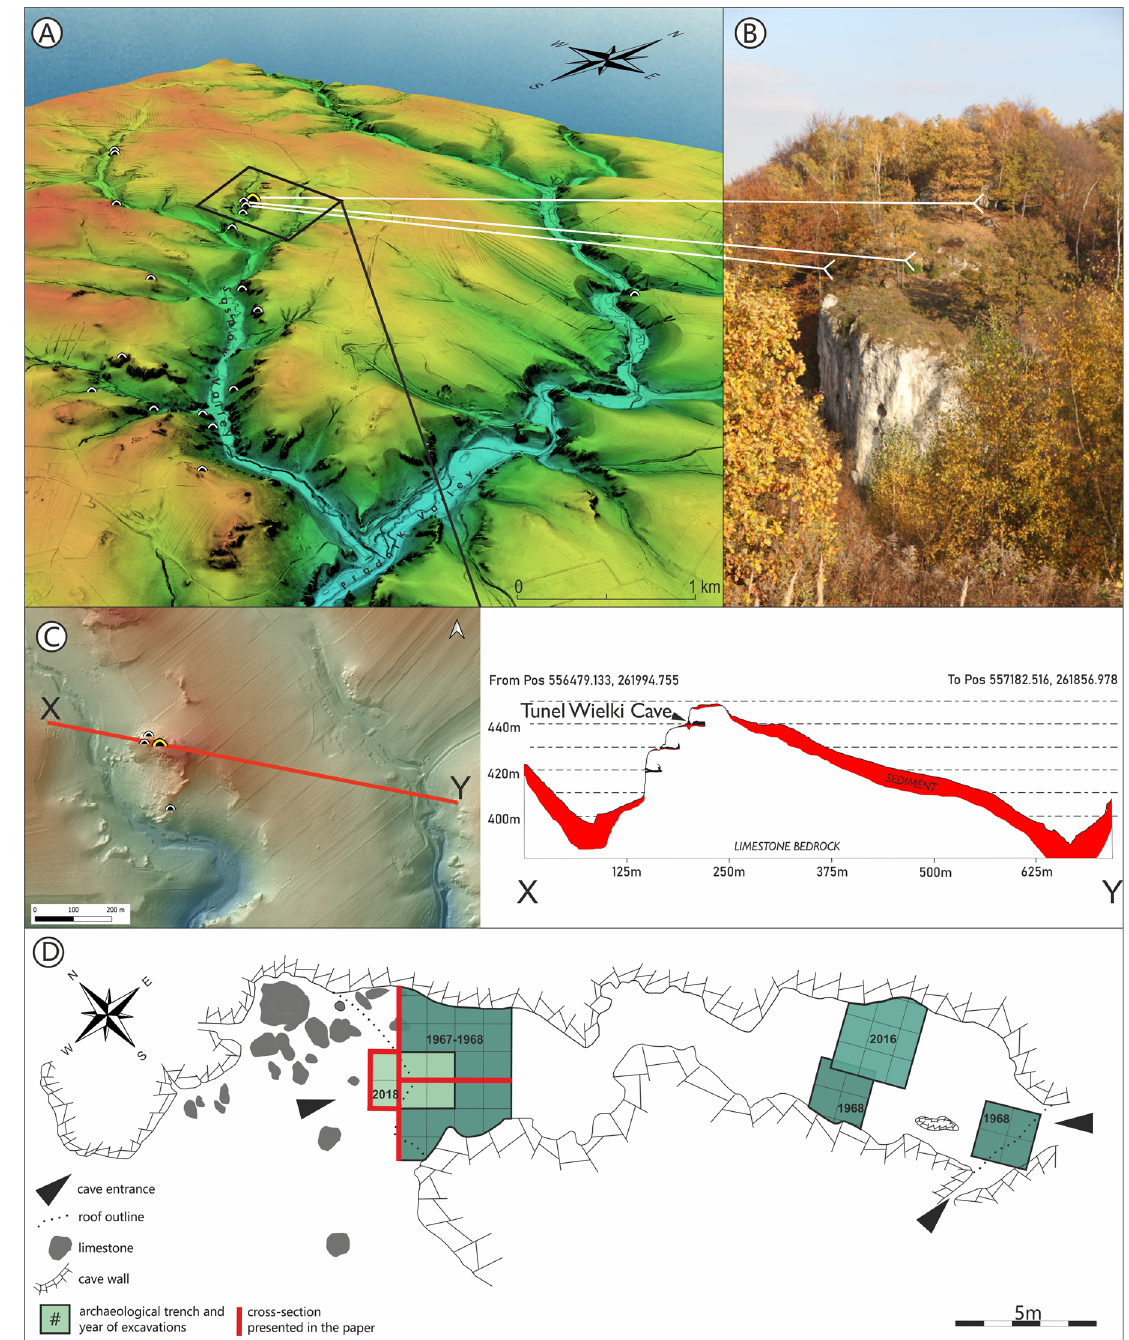
Figure 2. Location of Tunel Wielki Cave. A. Sadlane rocks with entrances of Tunel Wielki Cave on the top and two other archaeological sites ’Nad Niedostępną’ and ’Pod Tunelem’ Rockshelters located underneath. B. LiDAR map of a karstic region of the Sąspów and Prądnik valleys with location of Tunel Wielki Cave and other cave archaeological sites. C. Section through the Sadlane rocks. D. Plan of Tunel Wielki Cave with the exact location of the archaeological trenches (plan based on Madeyska 41 and 1967/68 fieldwork assemblage clearly indicated that, indeed, the cave sediments contained fauna belonging to two horizons 47 . The uppermost assemblage, related to the Late Pleistocene and the Holocene, was composed of a few remains of Dicrostonyx torquatus and Lemmus lemmus in the loess layers C and D, with a typical Holocene fauna in the upper layers A and B. The lower assemblage found within the loamy strata (layers F-P) is composed of a differ- ent list of rodent taxa, which were attributed, among others, to the following species: Arvicola mosbachensis , a small Alexandromys oeconomus , Allocricetus bursae , Microtus ( Terricola ) aff. arvalidens , Pliomys coronensis ( = Pliomys lenki) , and Pliomys episcopalis . Such a taxonomic composition allowed us to correlate this part of the